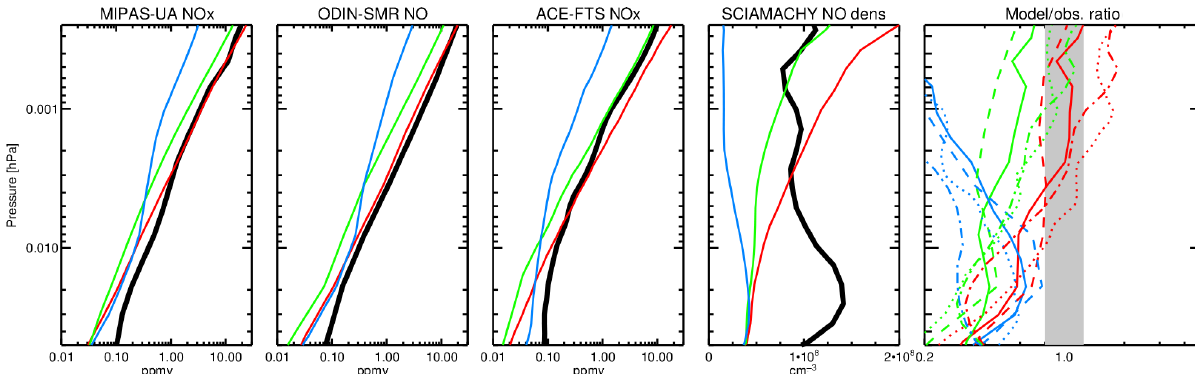
Figure 6. Comparison of observed NO x mean profiles (thick black lines) for February 2009 (during the ES event) and 70–90 ◦ N to 3dCTM (blue), HAMMONIA (green), and WACCM (red). Right panel: ratio of model results and MIPAS-UA (solid), SMR/Odin (dashed), ACE- FTS (dotted), and SCIAMACHY (dash-dotted) observations. The grey shaded area indicates the ± 25% range. Data have been averaged over 70–90 ◦ N and 1 February–1 March 2009 (60–90 ◦ N and 1 February 2008–15 March 2009 in the case of